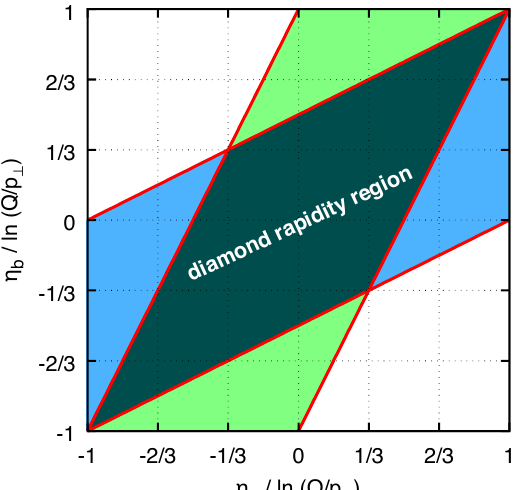
Figure 5. Representation of the di(cid:11)erent regions of rapidities for a pair of emissions with com- mensurate but small p ? values. The \diamond" rapidity region is that used for the analysis in this appendix and also in (cid:12)gure